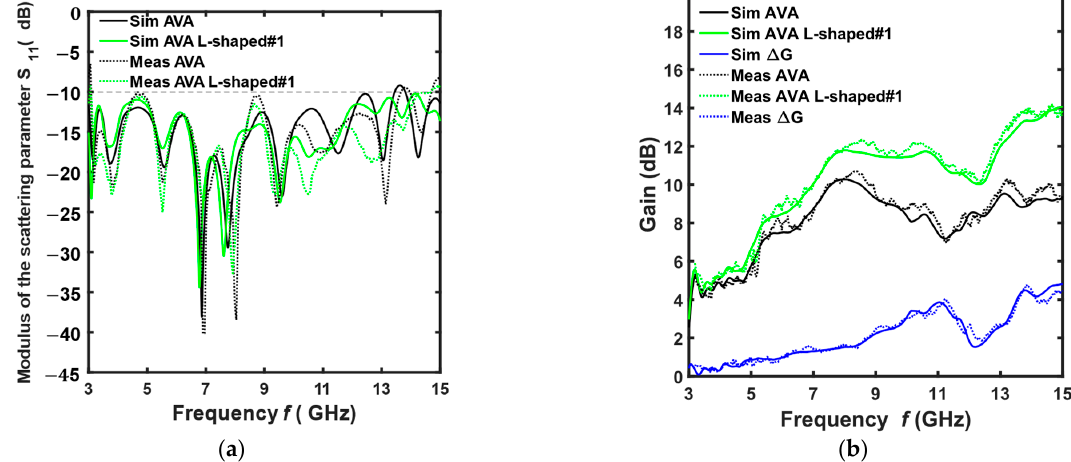
Figure 14. Comparison between full-wave simulation (solid curves) and measurement (dotted curves) of the AVA (black curves), and AVA L-shaped#1 (green curves): ( a ) modulus of the sca tt ering parameter |S 11 | as a function of frequency, and ( b ) realized gain ( 𝐺 ) and gain increase ( Δ𝐺 ) of frequency.